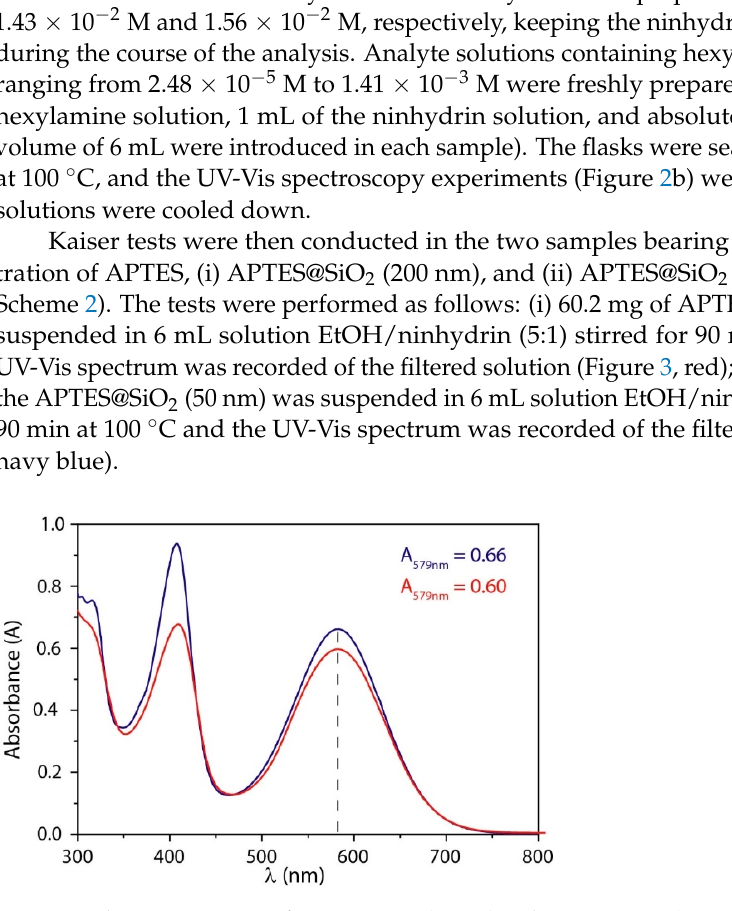
Figure 2. ( a ) Calibration curve; ( b ) absorption spectra of the different hexylamine solutions con- ducted by the Kaiser test.